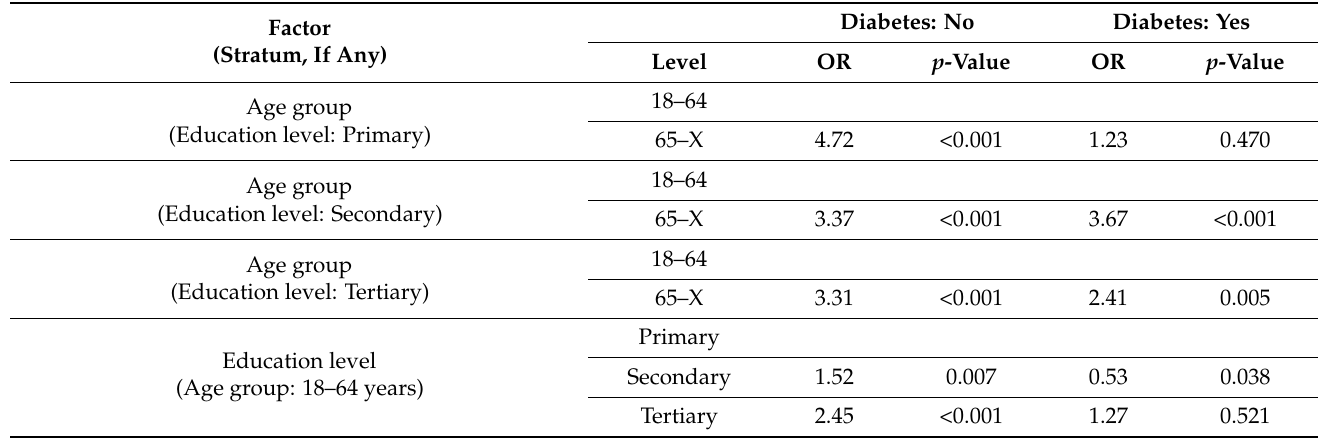
Table 2. Factors that influenced influenza vaccination among diabetic and non-diabetic respondents in Hungary based on a multivariate logistic regression